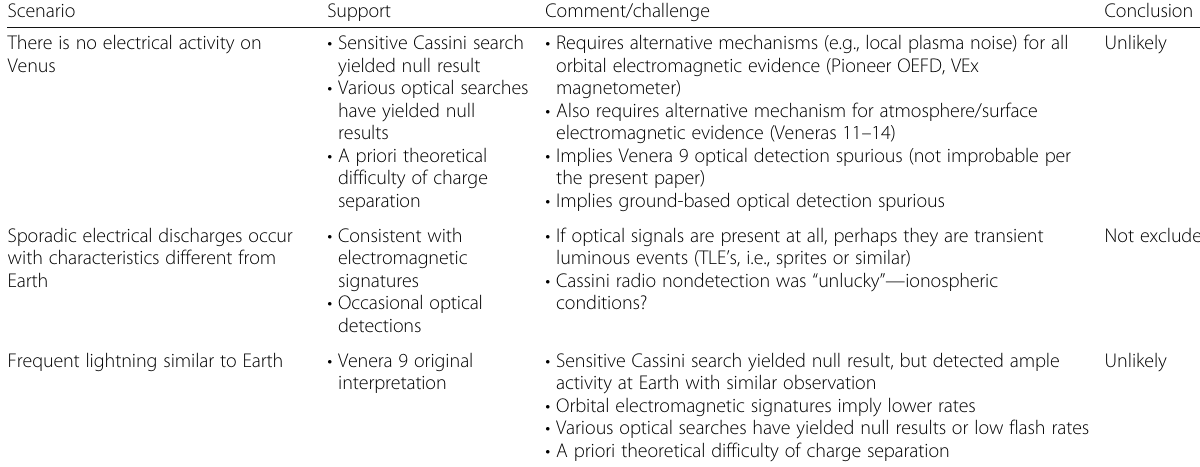
Table 4 Summary of hypotheses regarding Venus